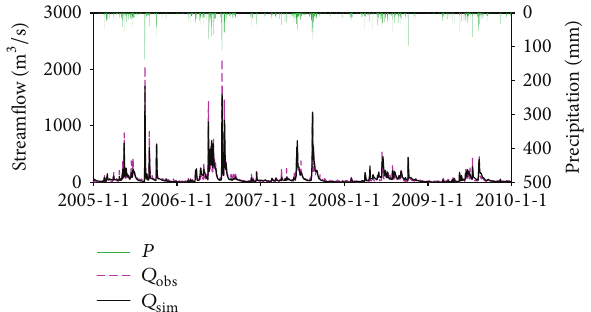
Figure 5: Streamflow simulations at Anxi station, where 𝑃 is is observed streamflow, and 𝑄 precipitation, 𝑄 obs streamflow by BTOPMC.